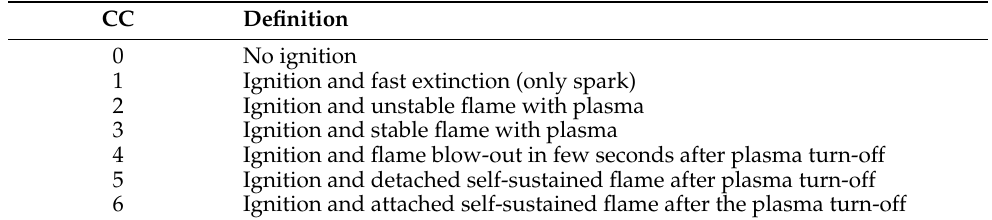
Table 3. Definition of Combustion Classes